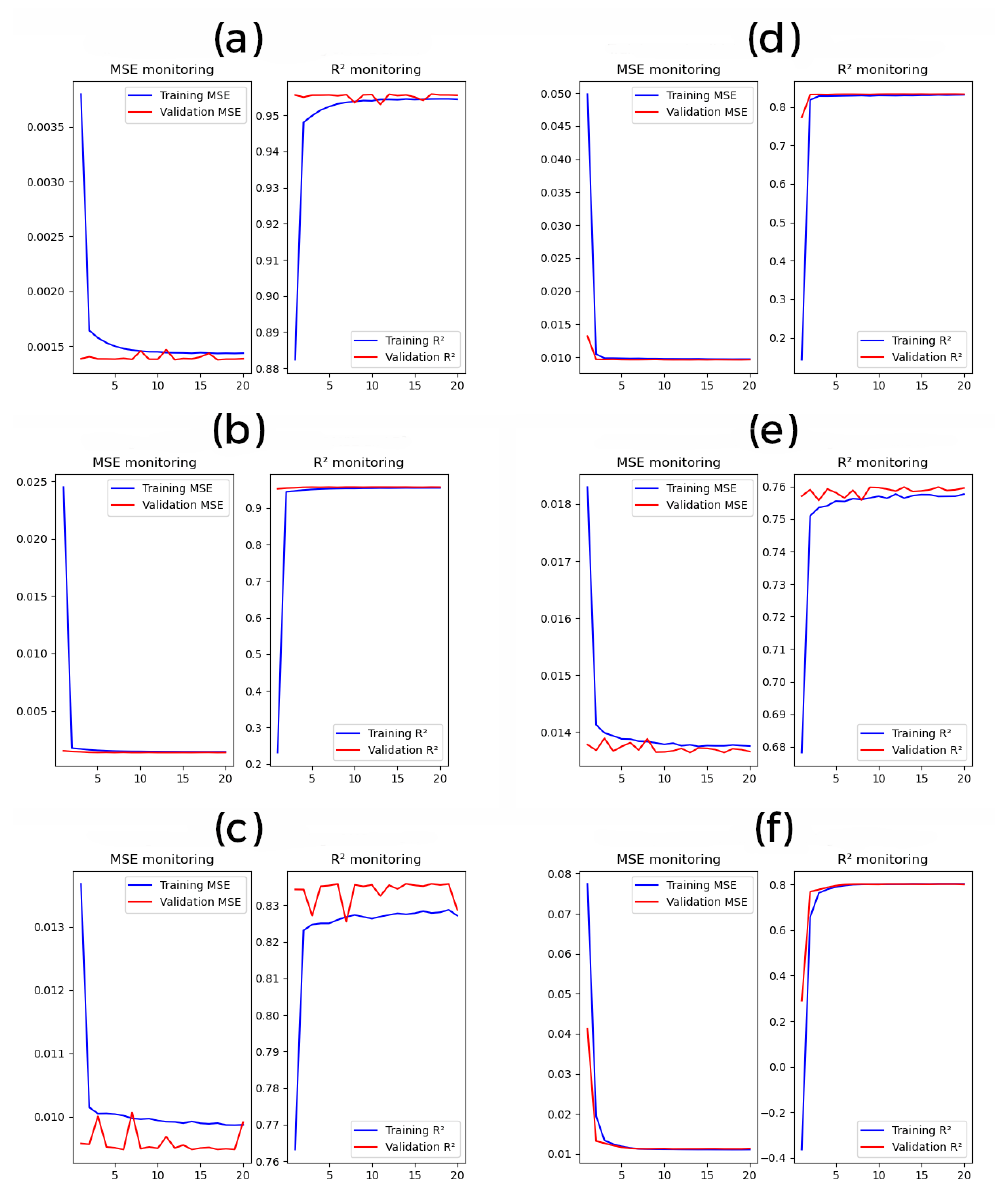
Figure 13. Monitoring of MSE and R 2 during training and validation phases: air temperature: ( a ) FFNN, ( b ) LSTM, global solar radiation: ( c ) FFNN, ( d ) LSTM, air relative humidity: ( e ) FFNN, ( f )